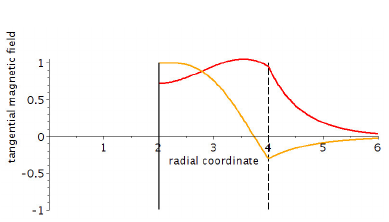
Figure 10. The tangential components Figure 11. The tangential components E z of electric field in case of H z of electric field in case of m = 1 , ω = 1. The permittivity is m = 1 , ω = 1. The permittivity is specified by ε c + ρ . specified by ε c + ρ . 20 20